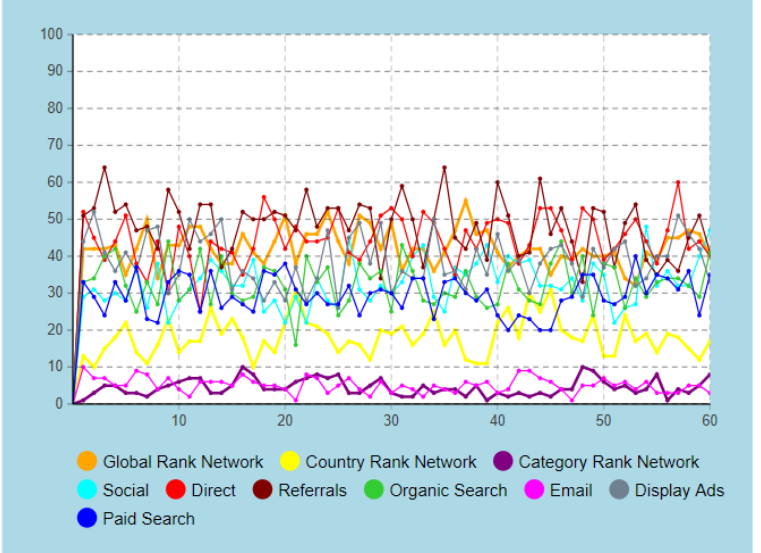
Figure 3. Time stack chart showing the values received by the parameters (GlobalRankNetwork, CountryRankNetwork, CategoryRankNetwork, Direct, Social, Referrals, OrganicSearch, Email, DisplayAds and PaidSearch) over the 60 day measurement period.